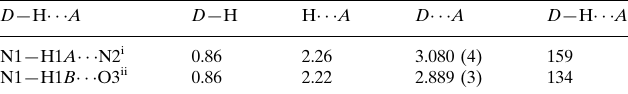
Hydrogen-bond geometry (A˚ , (cid:2)